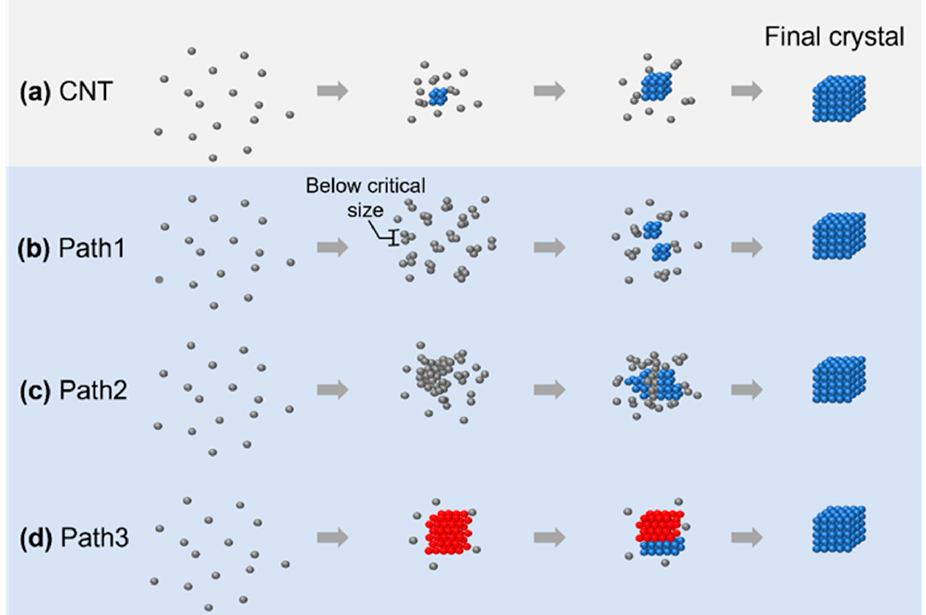
Figure 1. The four different crystallization pathways overviewed: ( a ) crystallization pathway de- scribed by classical nucleation theory; ( b – d ) three nonclassical nucleation pathways: formation of an amorphous cluster below critical nucleus size ( b ), nucleation of the crystalline phase from an amorphous intermediate ( c ), and transition between multiple crystalline structures before achieving the final product ( d ). The gray/red/blue spheres represent atoms or particles in a disordered/metastable crystalline/stable final crystalline structure, respectively.